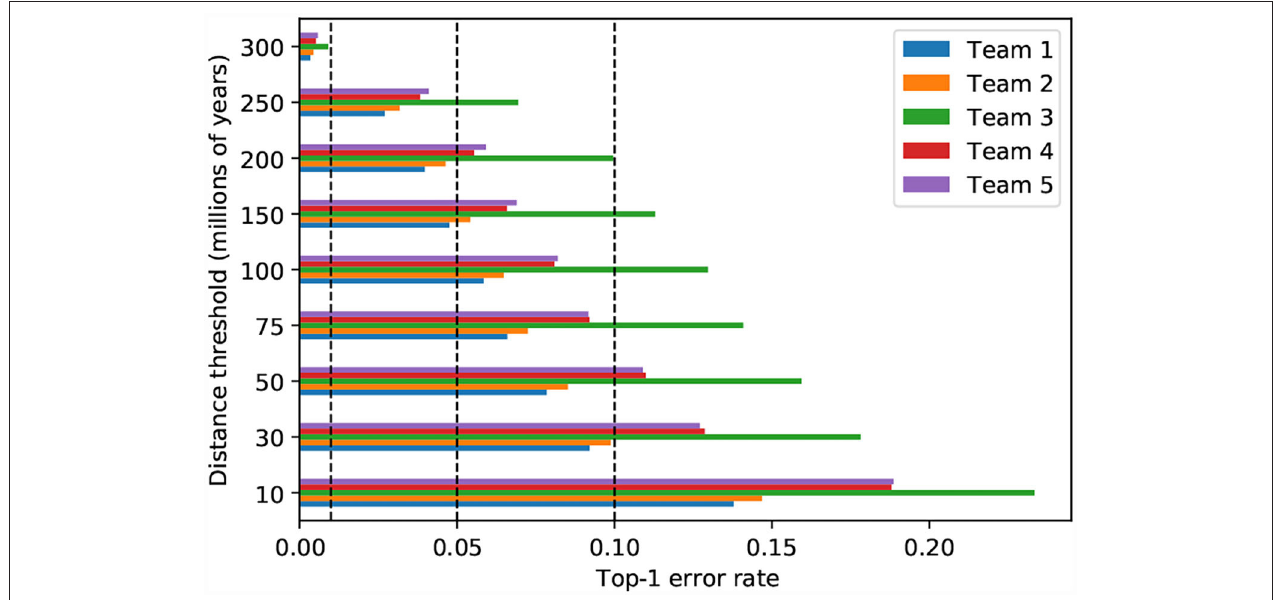
FIGURE 8 | Model performance measured by different phylogenetic proximity thresholds. Top-1 error is calculated by counting all predictions that are within the patristic distance threshold as successes. The vertical dashed lines represent top-1 error at 0.01, 0.05, and 0.10,